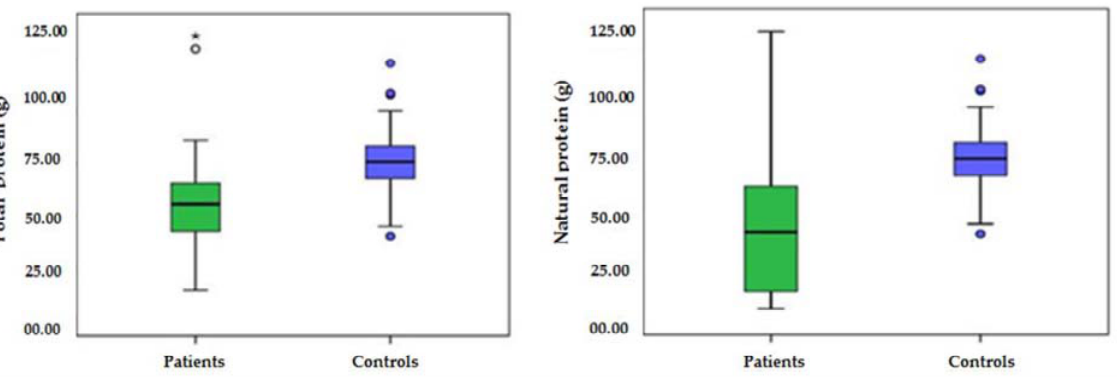
Figure 1. Protein intake in IEiM patients vs.